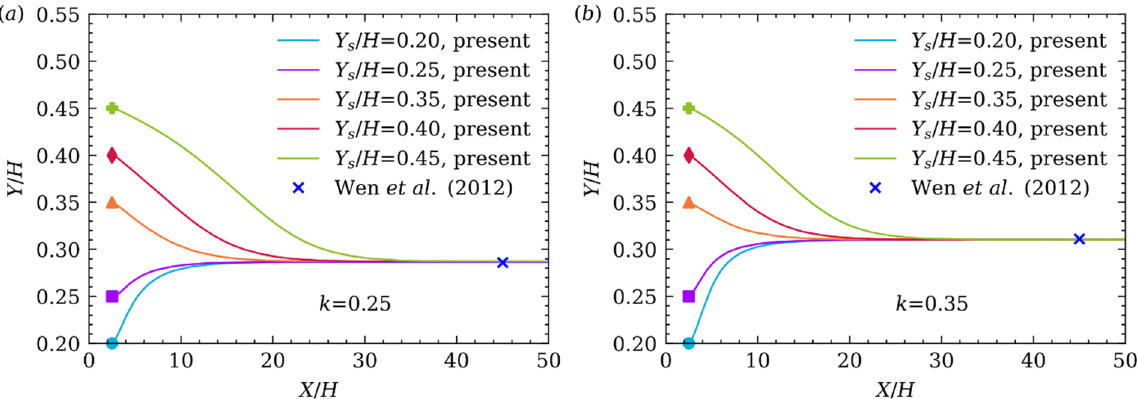
Figure 4. Lateral migration of the particle released from different initial positions in Poiseuille flow with ( a ) k = 0.25, ( b ) k = 0.35 .